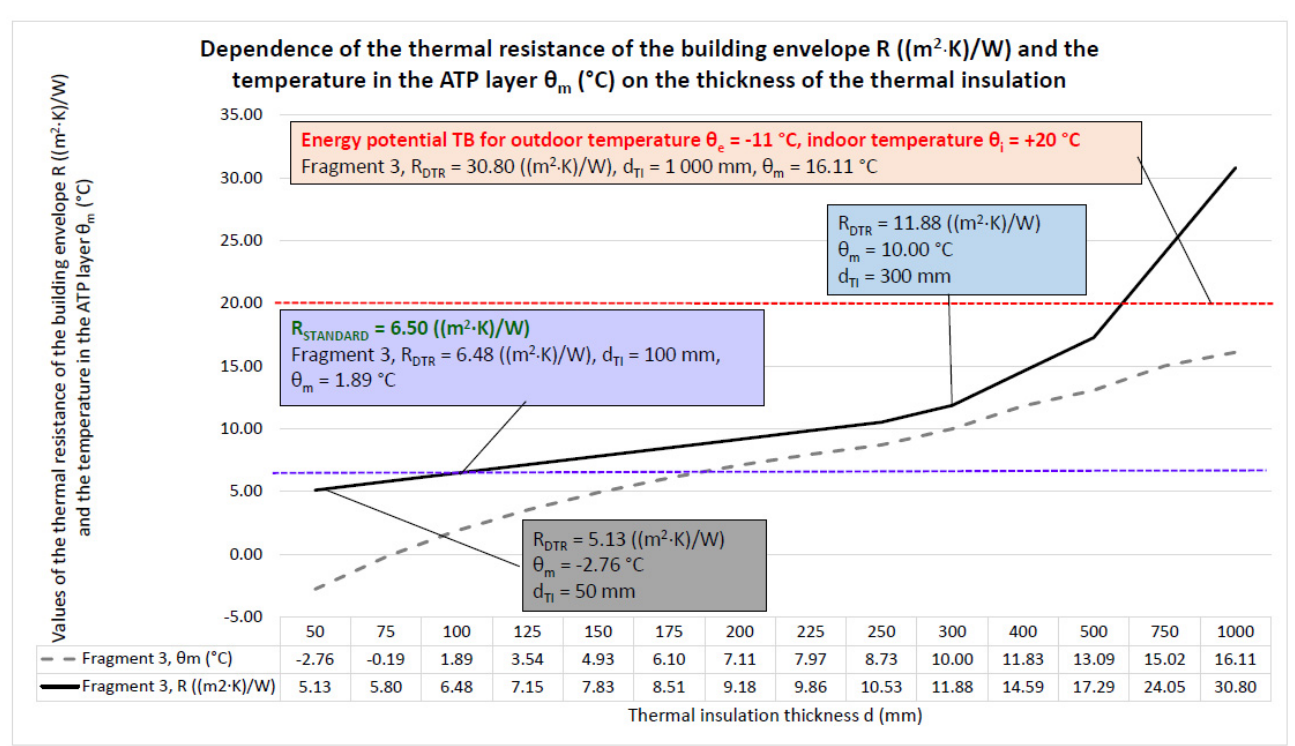
Figure 24. Graphical dependence of the dynamic thermal resistance on the thickness of the static/dynamic thermal insulation and the mean temperature of the heat transfer medium in the ATP pipes—Fragment 3.